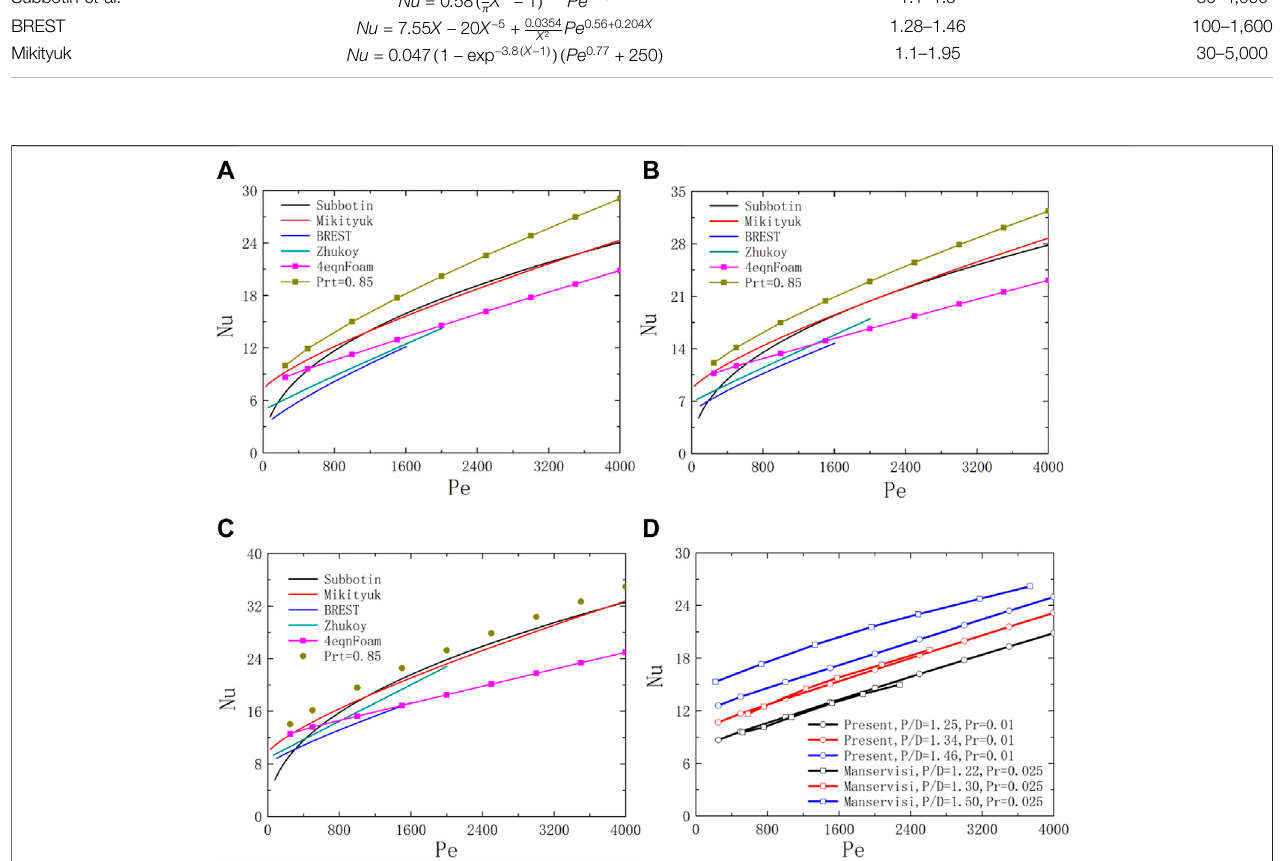
FIGURE 7 | Schematic diagram of Nusselt number for the square bundle. (A) X = 1.25; (B) X = 1.34; (C) X = 1.46; (D) X = 1.22 – 1.5.